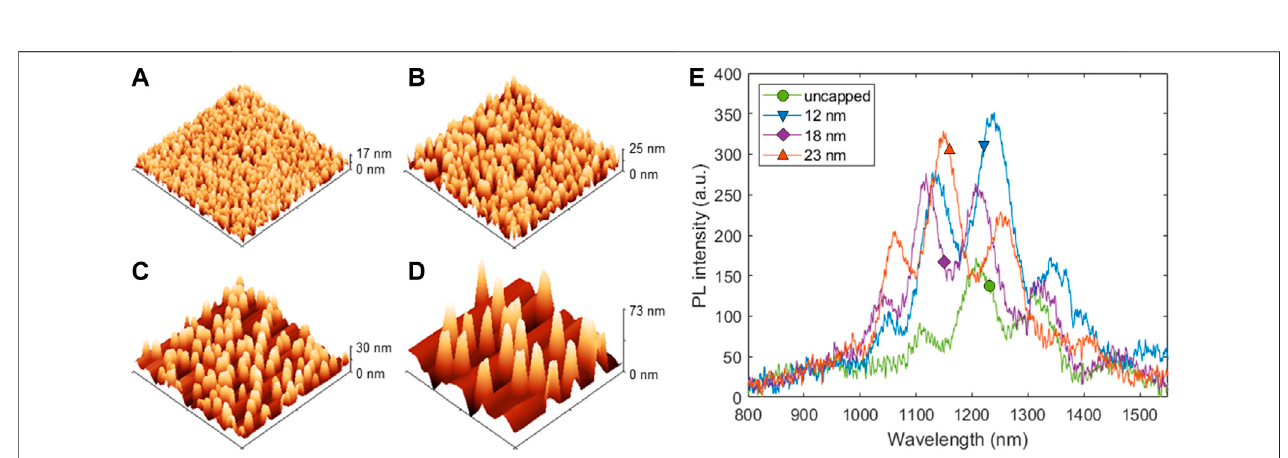
FIGURE 2 | (A) – (D) InN QDs in 3D atomic force micrographs; (1.5 μ m) 2 scans for QDs with growth temperatures of (A) 515, (B) 550, (C) 565, and (D) 600 ° C. (E) Roomtemperaturephotoluminescence(PL)fromInNQDs,excitedwitha780